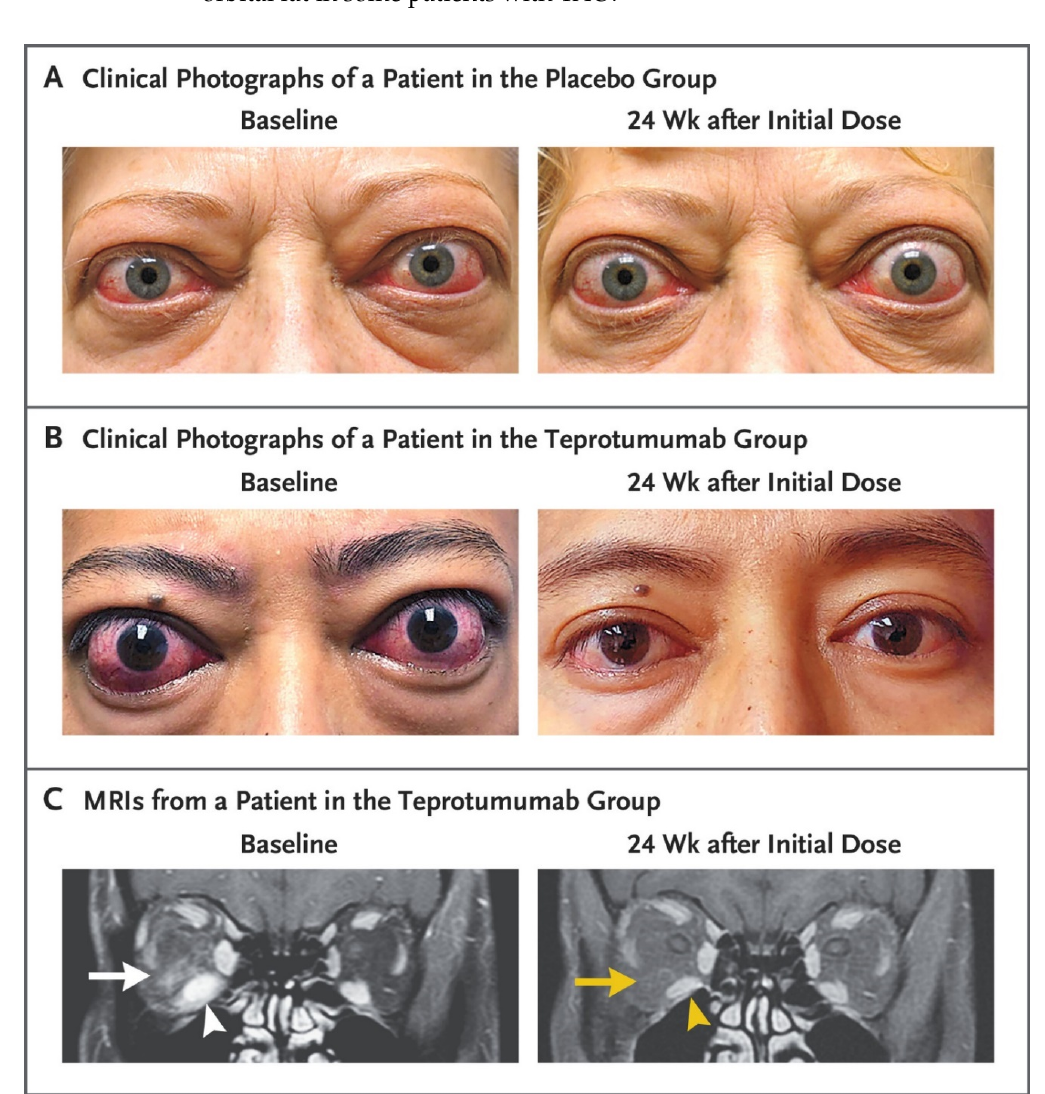
Figure 6. Photographs and MRIs at Baseline and 24 Weeks after receiving either placebo or teprotumumab in the Phase 3 trial. ( A ) Facial images of a patient receiving placebo. At baseline, substantial proptosis (left eye, 29 mm and right eye, 27 mm) and inflammatory signs (left eye Clinical Activity Score of 7 and right eye 5) are present. At week 24, proptosis and inflammation remain. ( B ) Facial images of a patient receiving teprotumumab. At baseline, proptosis (both eyes 24 mm), edema, upper and lower eyelid retraction, and multiple inflammatory signs (CAS 5 bilaterally) are present. At week 24, bilateral reductions in proptosis (−5 mm) and CAS (−4 points). ( C ). Contrast-enhanced, MRI shows fat-saturated T1- weighted coronal views in a single patient treated with teprotumumab at baseline and week 24. Enhancement of the inferior rectus muscle (white arrowhead) and orbital fat (white arrow) and nferior rectus muscle enlargement. At week 24, resolution of inferior rectus muscle (yellow arrowhead) enhancement and orbital fat (yellow arrow). Muscle volume was reduced by 49% (yellow arrowhead). Proptosis reduction decreased from 23 mm at baseline to 18 mm at week 24. From N. Engl. J.